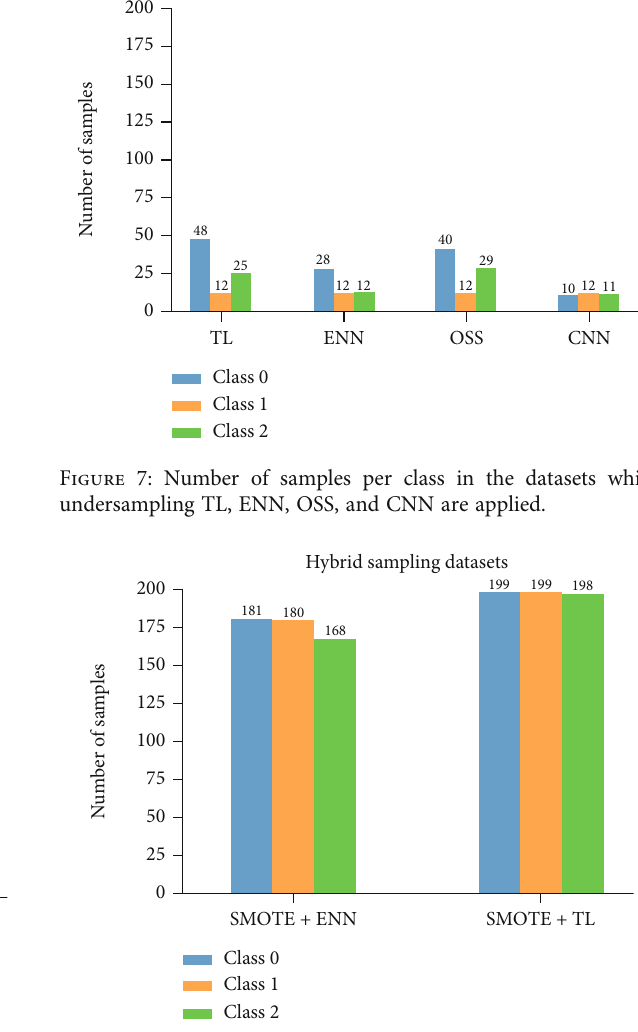
Figure 6: Number of samples per class in the datasets which oversampling SMOTE and ADASYN are applied.